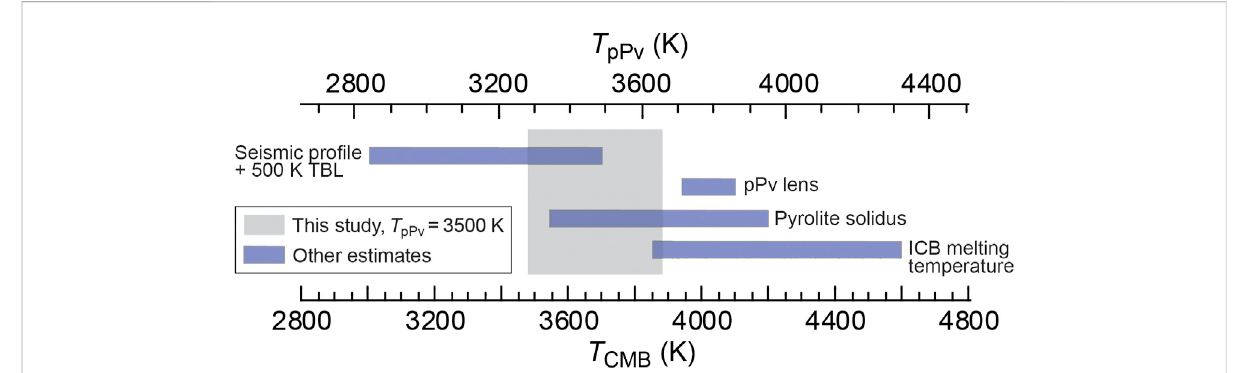
Comparison between our results and CMB temperatures, T CMB (bottom scale), estimated from radial seismic pro fi les, post-perovskite (pPv) lenses, pyrolite solidus at the CMB, and measurements of iron alloys melting temperature at the inner core boundary. The top scale shows the pPv transitiontemperatureattheCMB, T pPv ,calculatedbyinvertingEq.10.Thegrayareacoverstherangeof T CMB (95%likelihood)weobtainedfor T pPv = 3500 K (the range of uncertainty does not apply to the top